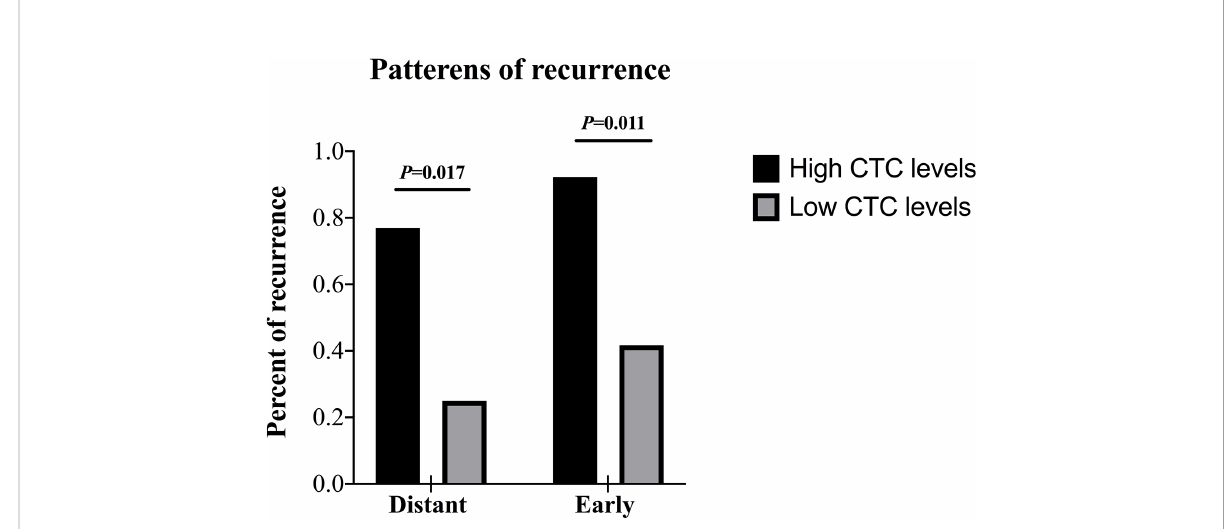
FIGURE 5 Patterns of recurrence of patients in the surgical group according to the CTC levels. CTC, circulating tumor